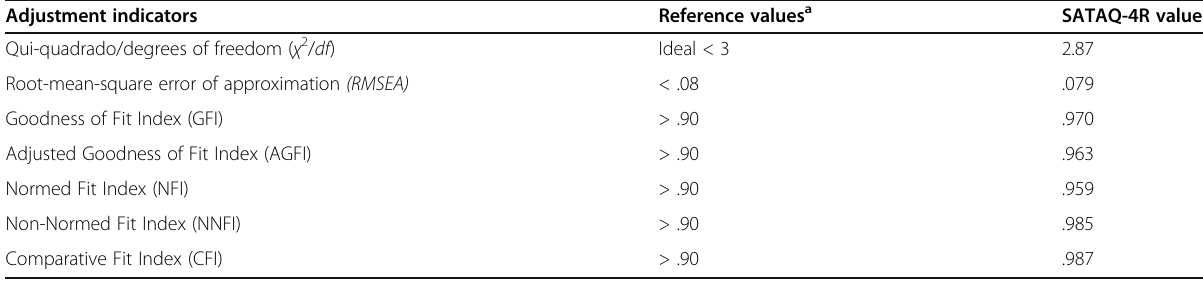
Table 7 Adjustment indicators of the SATAQ-4R for Brazilian boys Adjustment indicators Reference values a SATAQ-4R values Qui-quadrado/degrees of freedom ( χ 2 / df ) Ideal < 3 2.87 Root-mean-square error of approximation (RMSEA) <